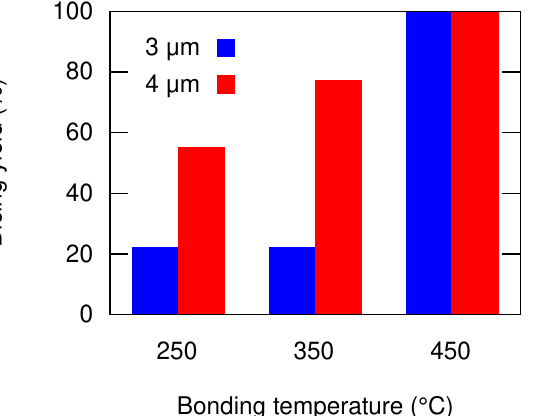
Figure 9. Bonding yield after wafer dicing with respect to the groove size and bonding